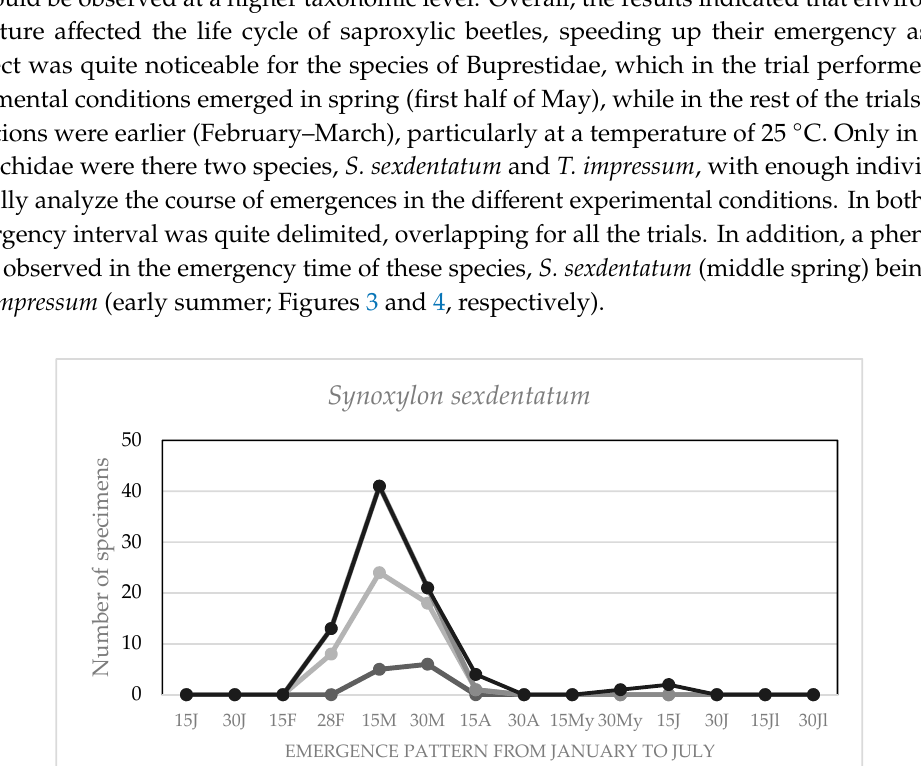
Figure 4. Emergence pattern of Trogoxylon impressum at temperatures °C from January to July. These observations were validated by the GLM analysis: The model dis no find significant differences in the temporal course of emergencies at different temperatures for any of the species (G = 0.375; p = 0.579 for S. sexdentatum; G = 0.378; p = 0.538 for T. impressum ). The number of specimens of Cerambycidae was very scarce (total 6) and the emergence occurred in April–May, except in the environmental conditions trial where no specimens were obtained throughout the entire follow-up. As for the predatory taxa, we considered firstly the Carabids, highlighting that most of the specimens were obtained in environmental conditions and later winter (January–March). Finally, the